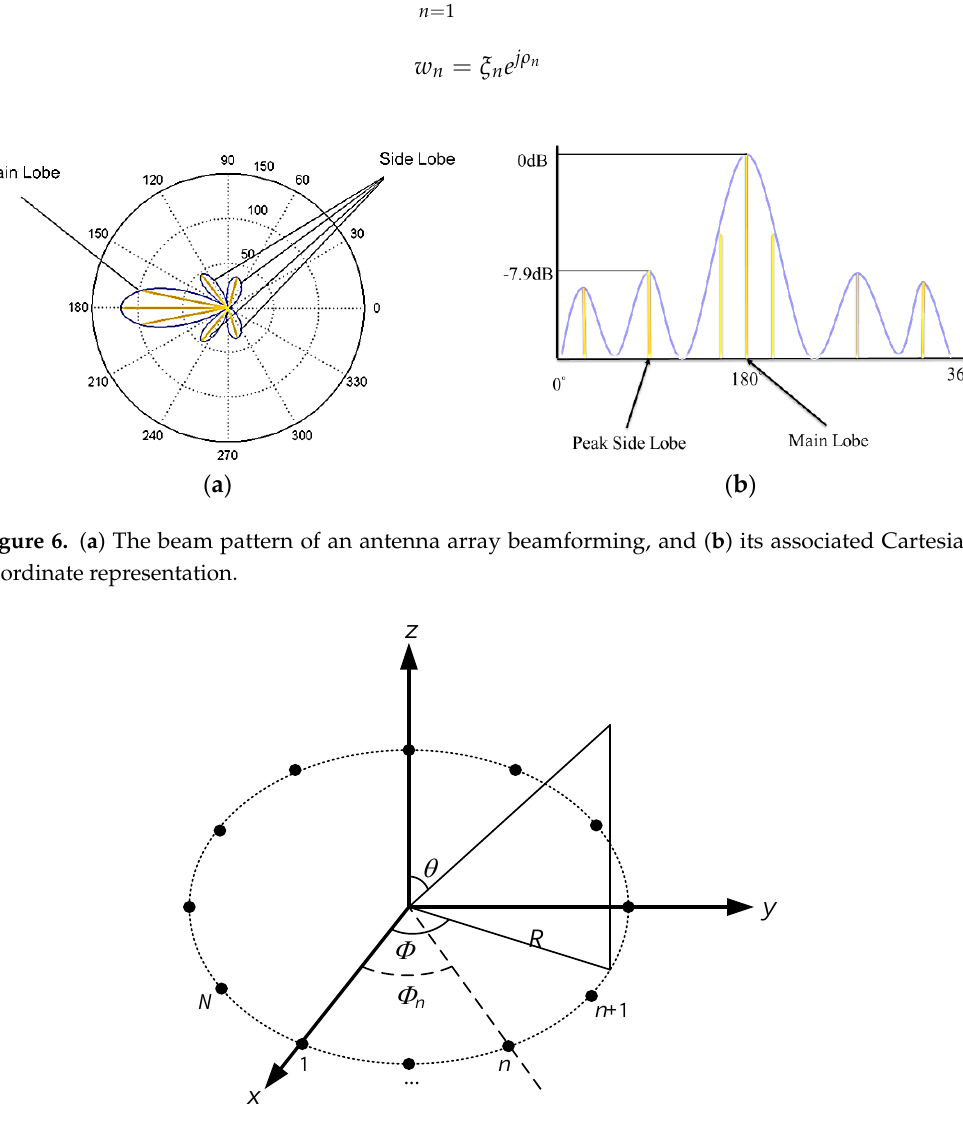
Figure 7. The geometric illustration of an N -element uniform circular array (UCA).